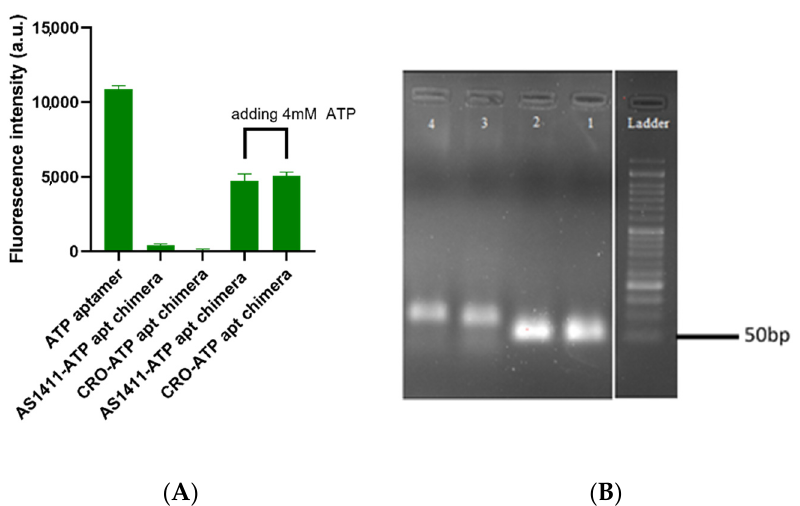
Figure 2. Detection of annealing of ATP aptamer with its complementary DNA, and the ATP-triggering dissociation of ATP aptamer from its complementary DNA strand. ( A ) Quenching-based analysis was used for annealing detection, and ATP triggering dissociates the ATP aptamer from its complementary DNA strand. Error bars indicate SD. ( n = 3). ( B ) Gel electrophoresis assay confirms that ATP aptamer hybridized with its complementary DNA. Lane 1: Unannealed DNA strand contains AS1411 aptamer, lane 2: Unannealed DNA strand contains CRO, lane 3: formed AS1411–ATP aptamer chimera, lane 4: formed CRO–ATP aptamer chimera.